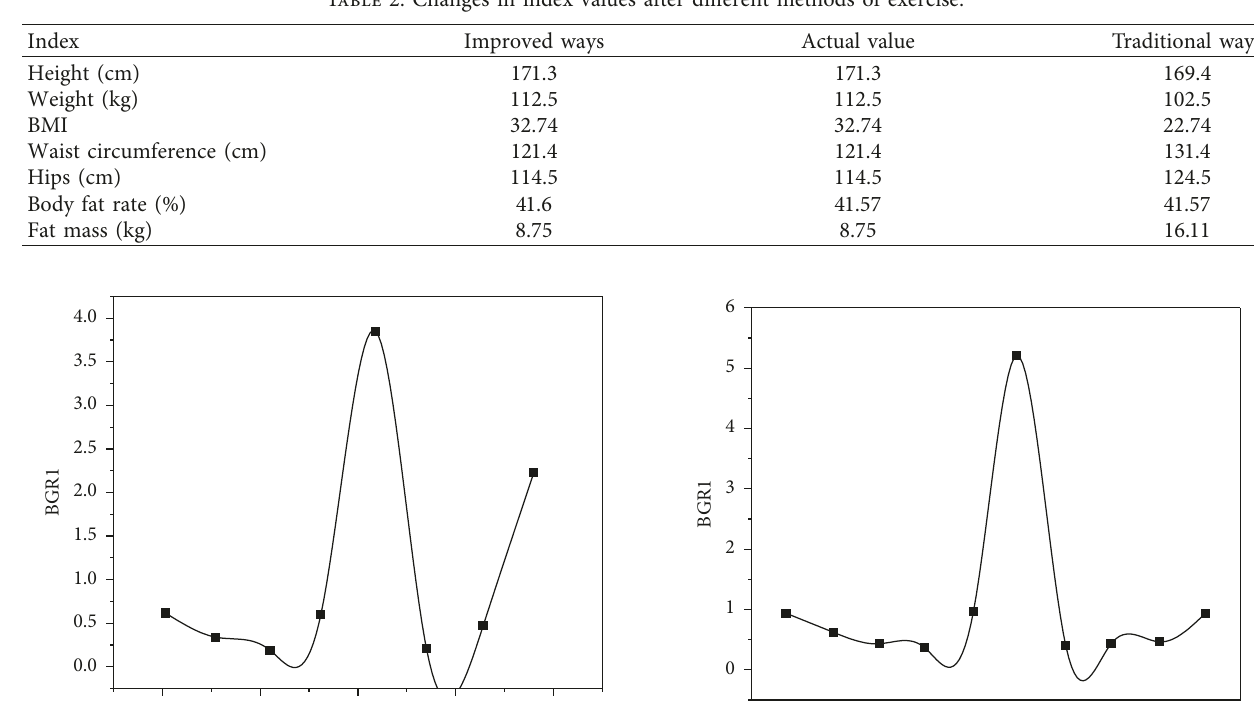
Table 2: Changes in index values after different methods of exercise.